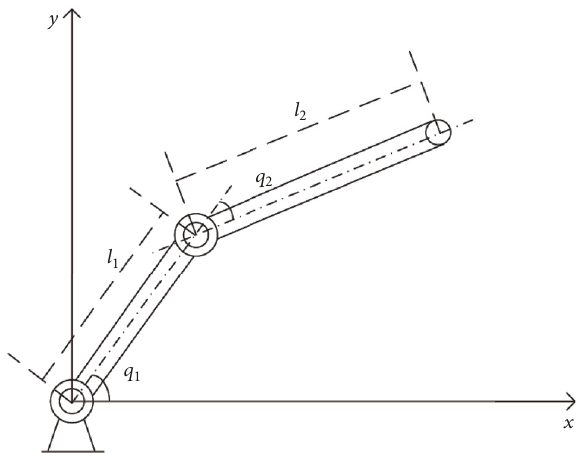
Figure 1: Diagram of a 2-link robotic